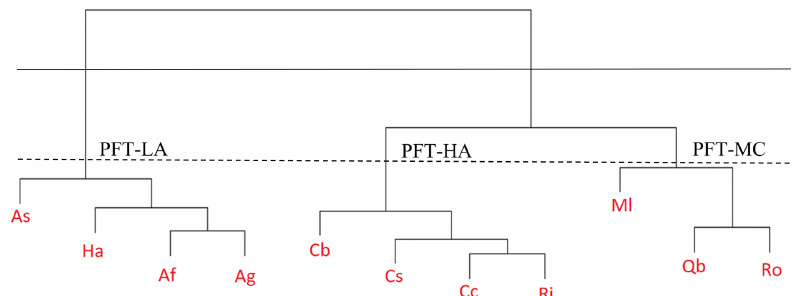
Figure 1. Hierarchical cluster analysis of allometry and hydraulic traits for 11 chaparral shrub species used to define three plant functional types at Stunt Ranch. The plant functional types with a low productivity and an aggressive drought tolerance hydraulic strategy (PFT-LA) were defined based on traits of red shank (Adenostoma sparsifolium – As), toyon (Heteromeles arbutifolia – Ha), chamise (Adenostoma fasciculatum – Af), and big berry manzanita (Arctostaphylos glauca – Ag). The plant functional types with a high productivity and an aggressive drought tolerance hydraulic strategy (PFT-HA) were defined based on traits of mountain mahogany (Cercocarpus betuloides – Cb), greenbark ceanothus (Ceanothus spinosus – Cs), buck brush (Ceanothus cuneatus – Cc), and hollyleaf redberry (Rhamnus ilicifolia – Ri). The plant functional types with a medium productivity and an conservative drought tolerance hydraulic strategy (PFT-MC) were defined based on traits of laurel sumac (Malosma laurina – Ml), scrub oak (Quercus berberidifolia – Qb), and sugar bush (Rhus ovata –